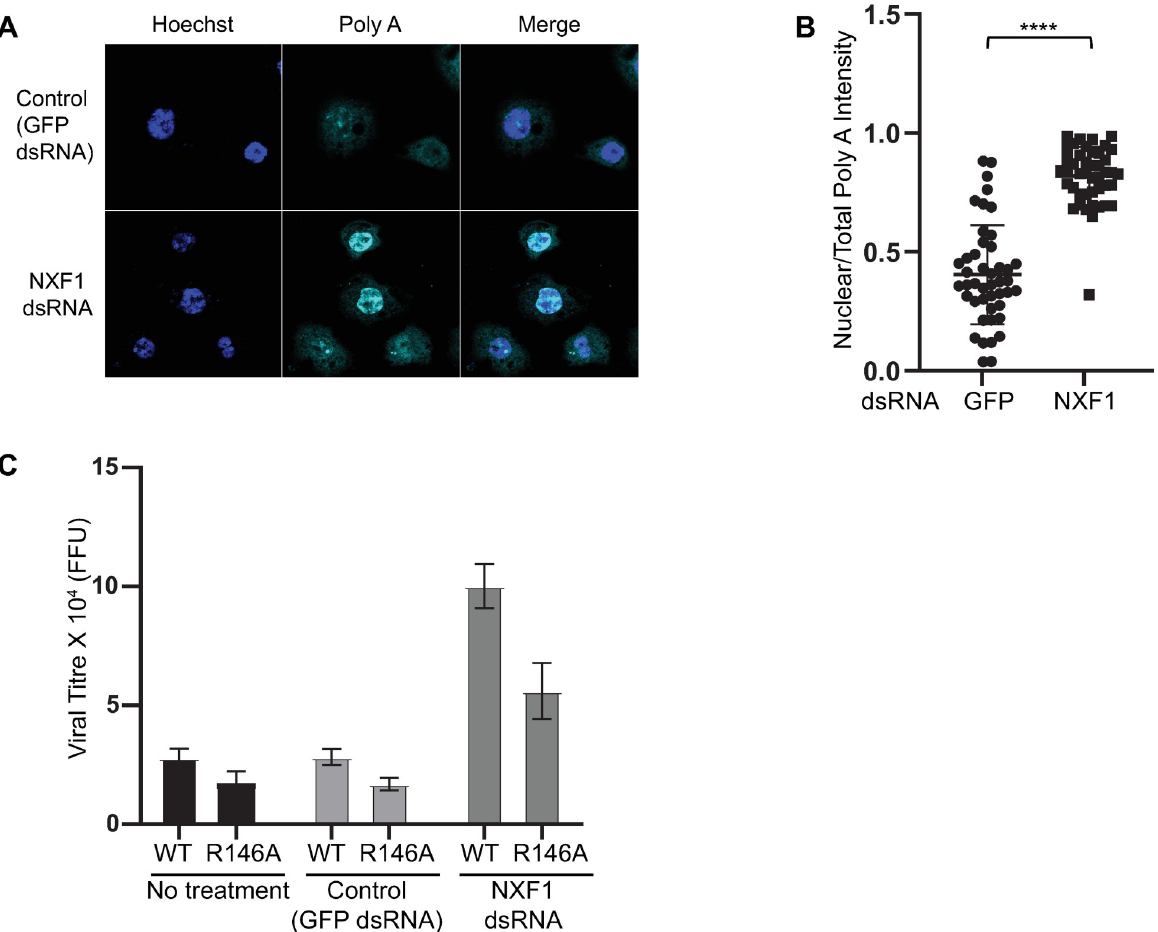
Fig 7. RNA export modulates CrPV infection. (A) Fluorescence in situ hybridization using Cy5-oligo(dT) (cyan) of S2 cells incubated with dsRNA targeting RNA export factor NXF1 or control GFP and Hoechst dye (blue). Images were taken using the Leica Sp5 confocal microscope with a 63X objective lens and 3X zoom. (B) Box plot of the fraction of nuclear to total Cy5-oligo(dT) fluorescence intensity in each cell. At least 40 cells were counted for each condition from two independent experiments. Data are mean ± SD. p < 0.0001( ���� ) by a student t-test. (C) Viral yield from wild-type and mutant (R146A) CrPV infected S2 cells for 8 hours (MOI 10) was accessed by fluorescence foci unit (FFU). Shown are averages from two independent experiments.